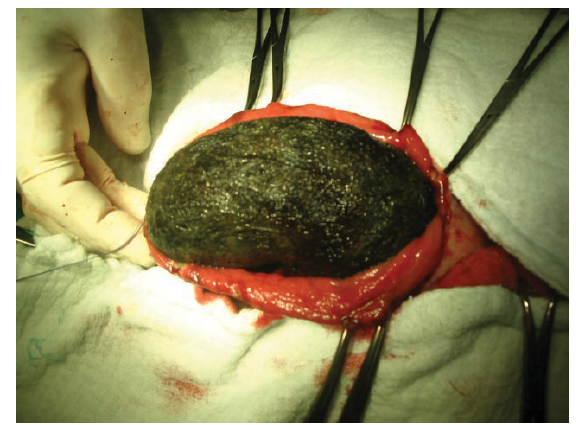
Figure 1. Extraction of a trichobezoar through gastrotomy.